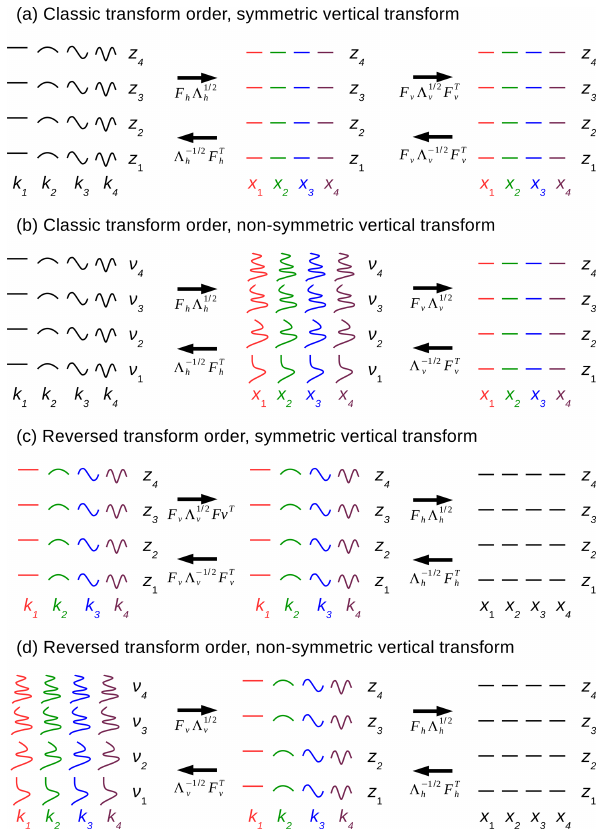
Figure 1. Schema to illustrate the different options for the spatial transforms as indicated by the panel titles (these are combinations of classic and reversed transform orders and symmetric and non- symmetric vertical transforms). Representations of the vertical di- rection include model levels (labelled with z 1 , z 2 , etc.) and verti- cal modes ( ν 1 , ν 2 , etc.). Representations of the horizontal direc- tion include model grid points ( x 1 , x 2 , etc.) and Fourier modes ( k 1 , k 2 , etc.). Moving from left to right indicates the forward transform and from right to left indicates the inverse transform. The horizon- tal transform is always done independently for each vertical co- ordinate ( z i to z i or ν i to ν i ), and the vertical transform is always done independently for each horizontal co-ordinate ( x i to x i or k i to k i , as guided by the colours). The co-ordinates used in the control space in each option are indicated on the leftmost